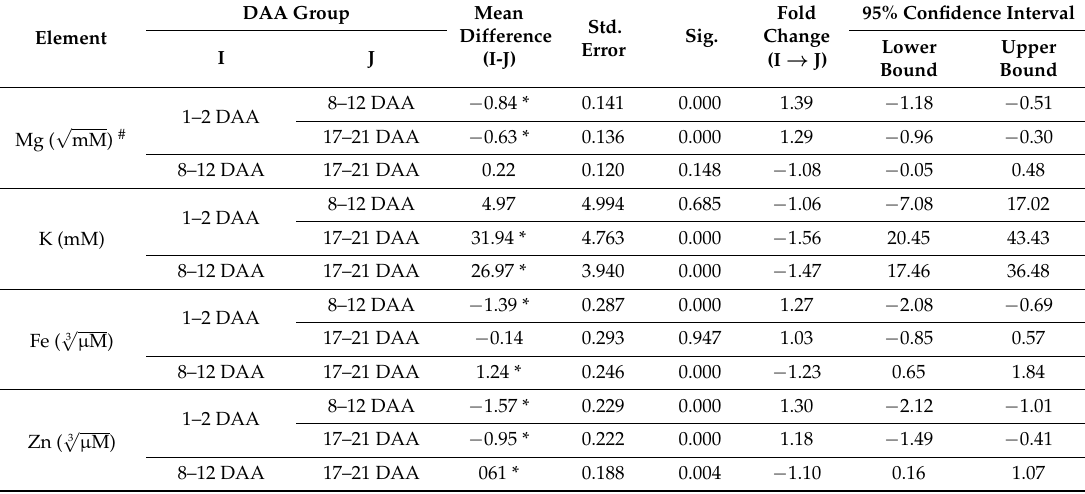
Table 2. Hochberg GT2 post hoc test results for comparing maturity groupings after two-way ANOVA.